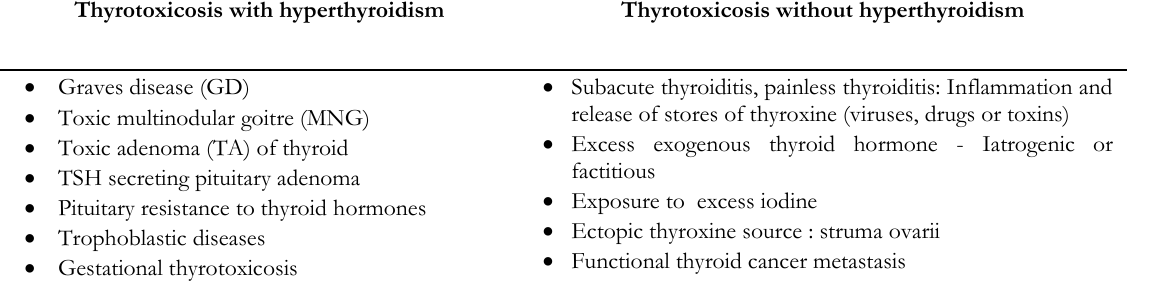
Table 3.2. Causes of